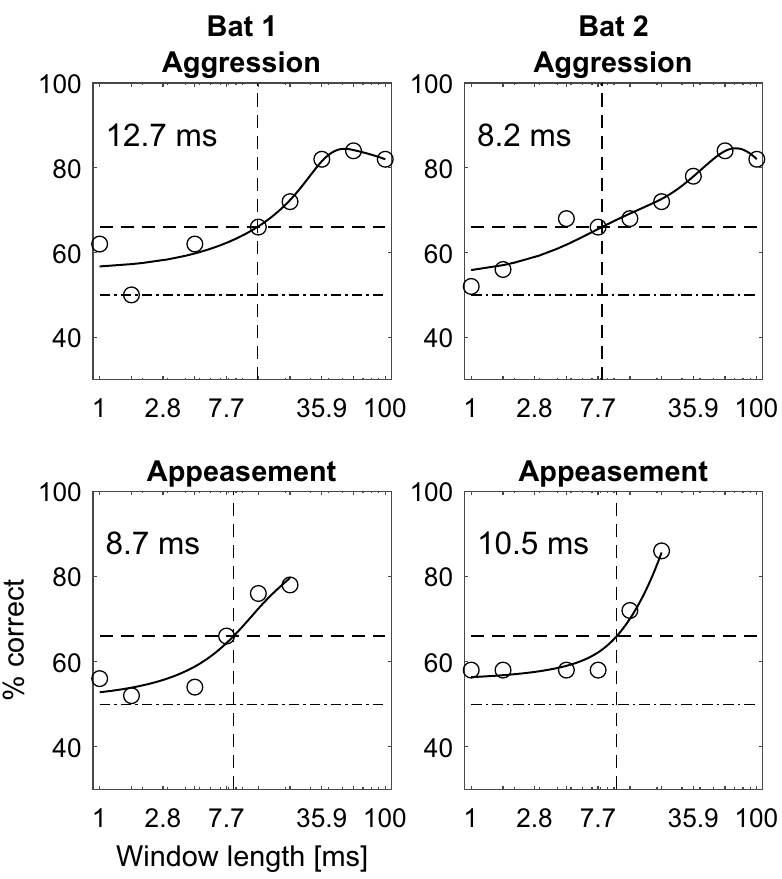
Figure 4. Psychometric functions of discrimination performance. For aggression calls, the psychometric functions yield threshold window-lengths of 12.7 and 8.2 ms for Bat 1 and Bat 2, respectively. For appeasement calls, the psychometric functions yield threshold window-lengths (vertical dashed lines) of 8.7 and 10.5 ms for Bat 1 and Bat 2, respectively. Note that the maximum window length for appeasement calls is 21.54 ms, owing to the short duration of these calls. Each circle marks a bat’s discrimination performance across 50 trials. Horizontal dashed lines at 50% and 66% correct depict chance and significance level (binomial test, 50 trials, p < 0.01),